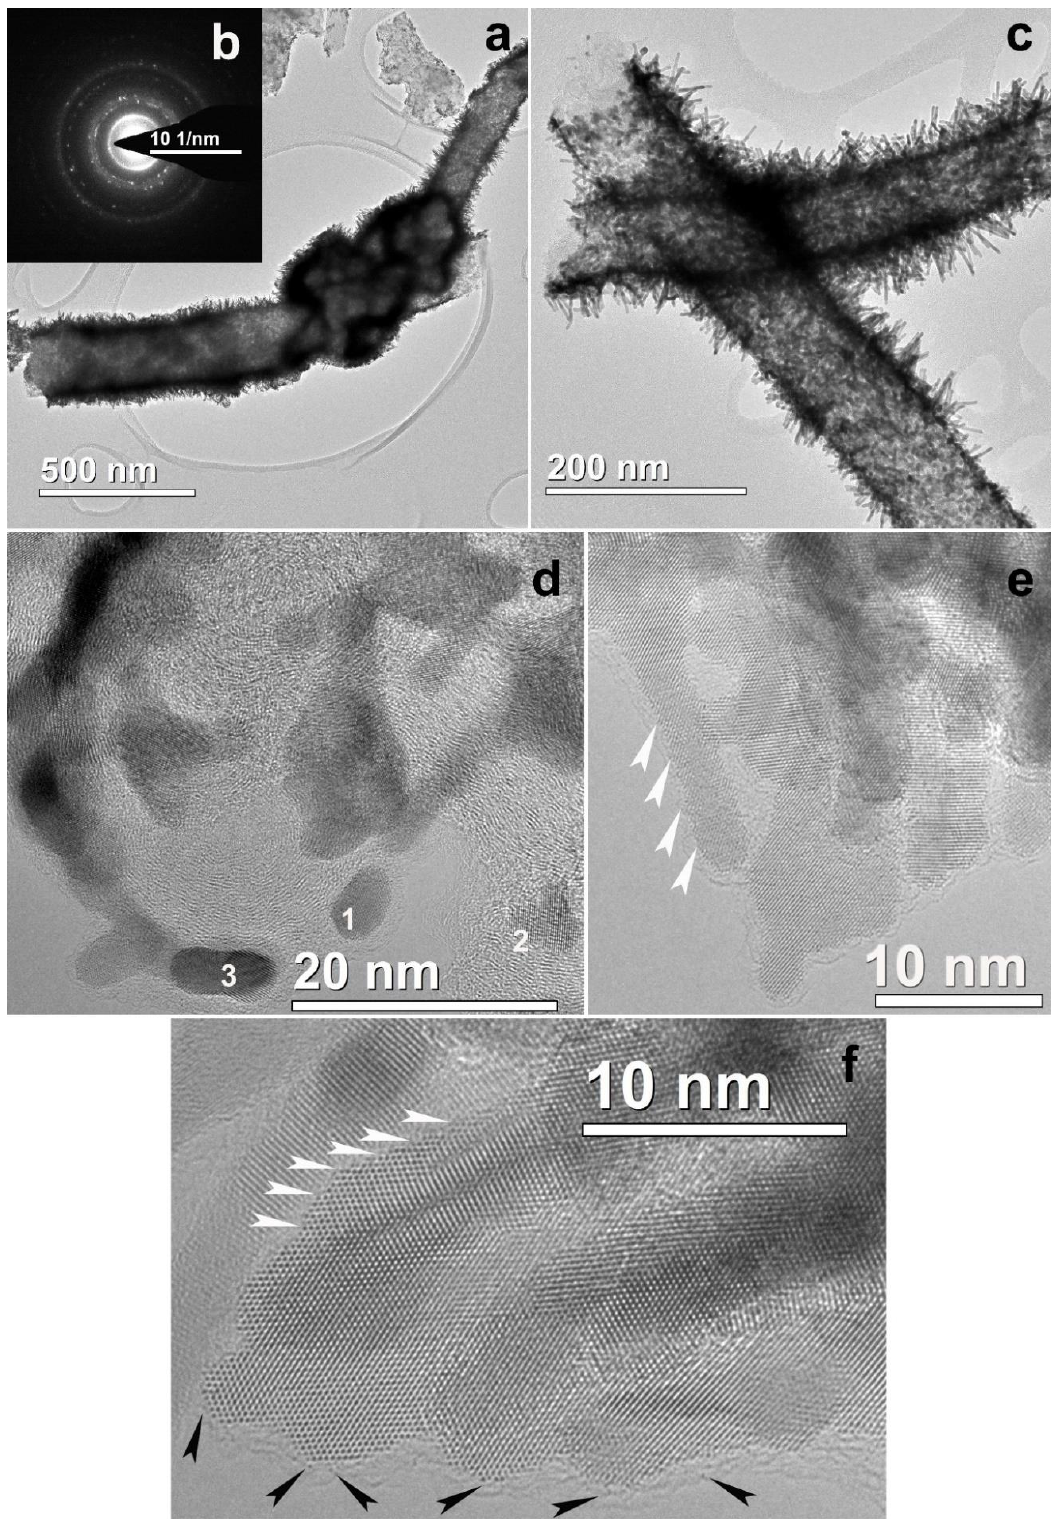
Figure 7. Structure of platinated composite Pt / 2: ( a ) CNF with carbon black and ( b ) corresponding selected area electron diffraction (SAED) pattern; ( c ) needle-like long Pt on CNF; ( d ) carbon black influence on Pt particle morphology (1,2—Pt particles; 3—Ni particles); ( e ) HRTEM image of needle-like Pt with monoatomic steps; ( f ) fine structure of Pt crystals of intermediate (random) shape. Ledge-steps are shown with white arrows, isolate atoms are shown with black arrows.